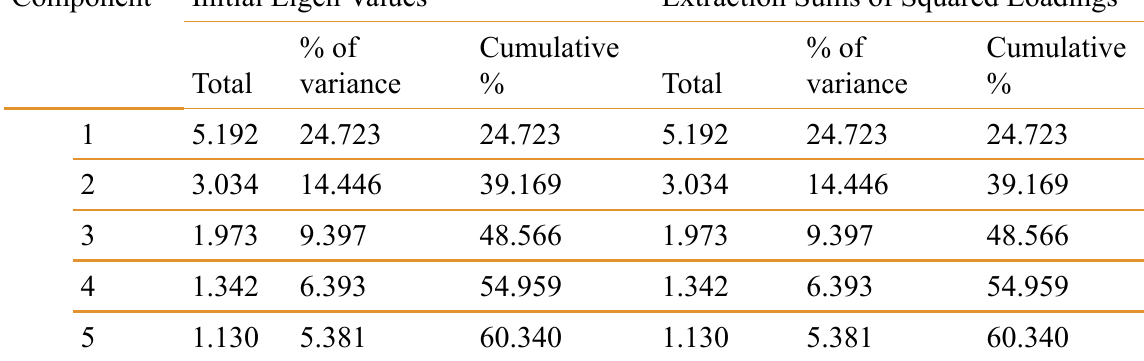
Table 3 Variance Explained by Each of the Factors